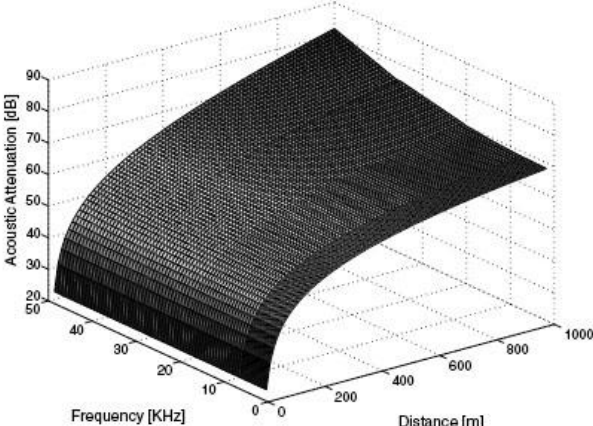
Figure 2. The attenuation of the acoustic signal.